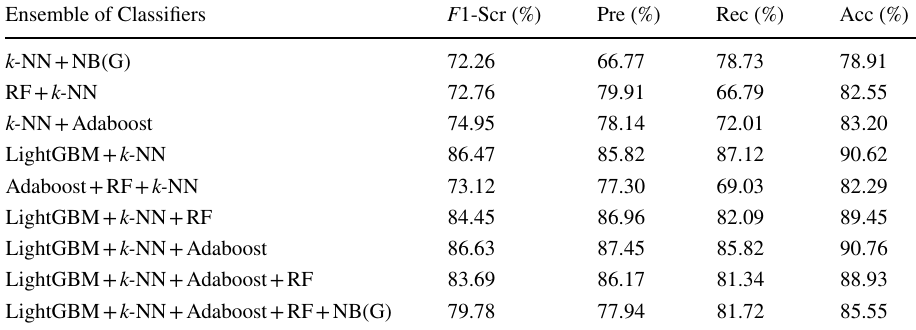
about fivefold cross-validation of various hybrid ensemble models along with the proposed LightGBM + k -NN + Adaboost